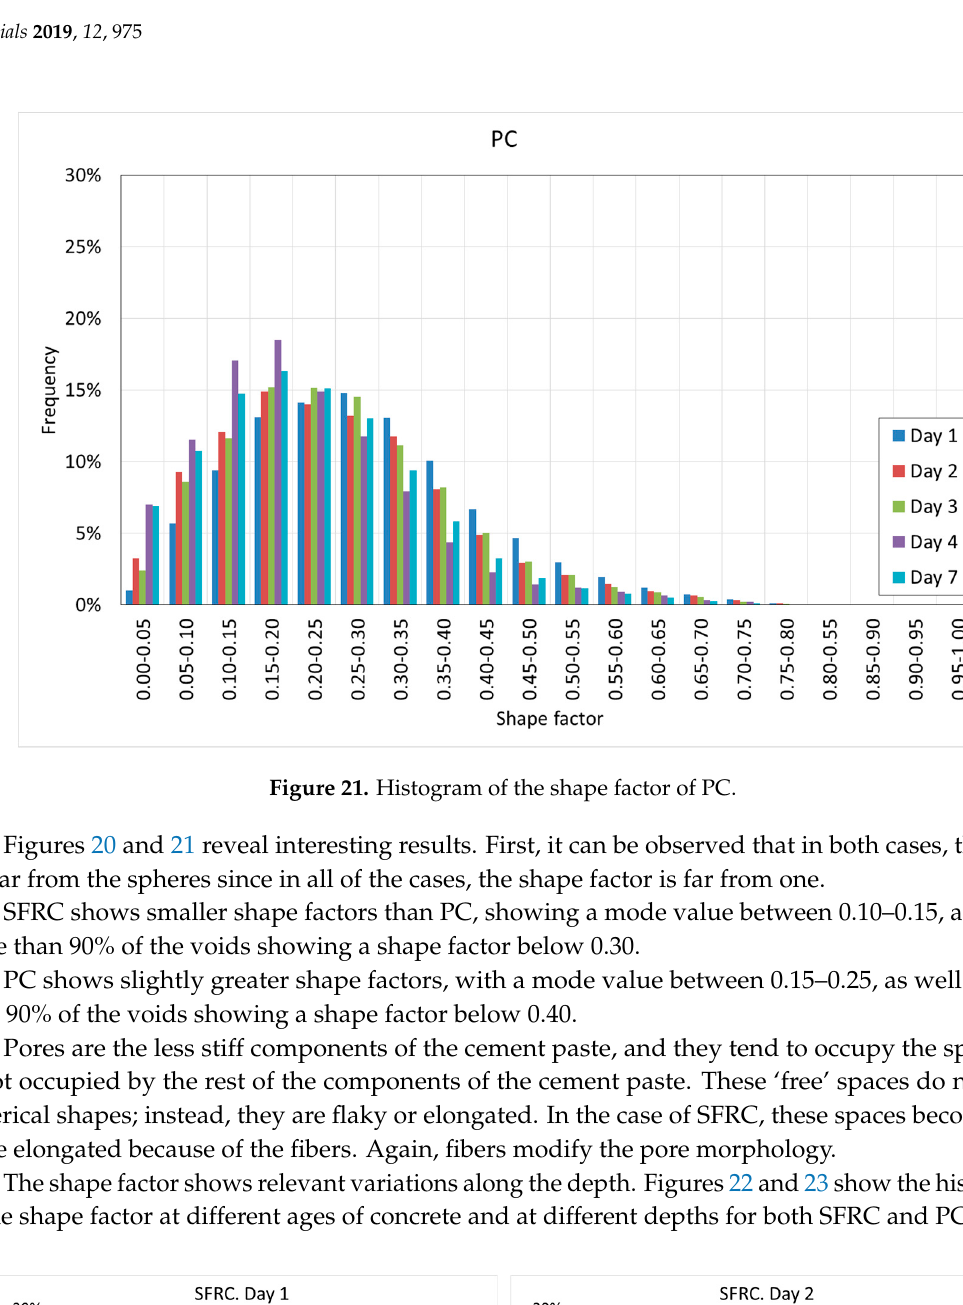
Figure 20. Histogram of the shape factor of SFRC.